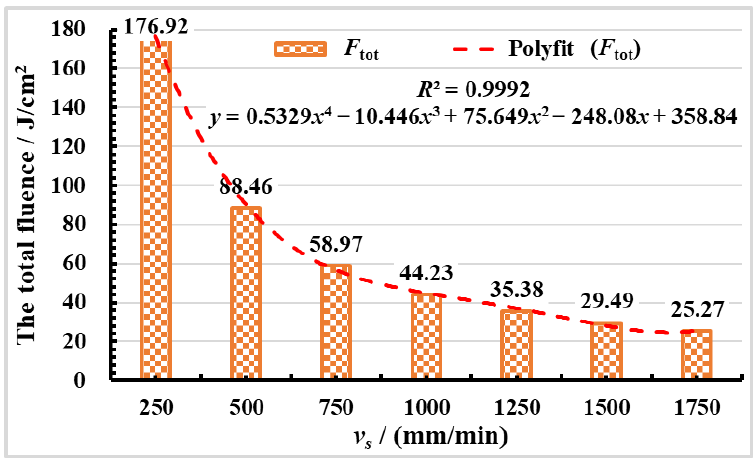
Figure 6. Variations of the total fluence with laser scanning speed.